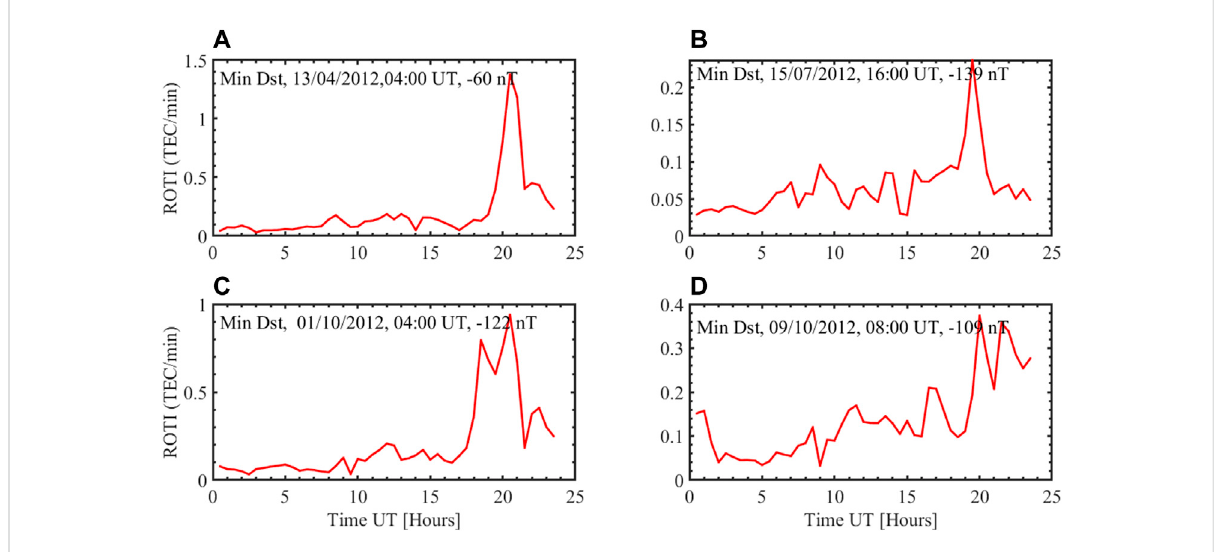
FIGURE 1 Variation of ROTI collectively computed from all stations in Table 1, with the time of the day, during geomagnetically active days. The UT in the time scale isone (1) hour behind Nigerian localtime (LT). Dst, Minindices ranged from − 139to − 60 nT.The ROTI wascalculated ata30-mininterval. (A) shows variation ROTI with Dst, Min of − 60 nT on 13/04/2012, 04:00 UT, (B) shows variation ROTI with Dst, Min of − 139 nT on 15/07/2012, 16:00 UT, (C) shows variation ROTI with Dst, Min of − 122 nT on 01/10/2012, 04:00 UT and (D) shows variation ROTI with Dst, Min of − 109 nT on, 09/ 10/201208:00